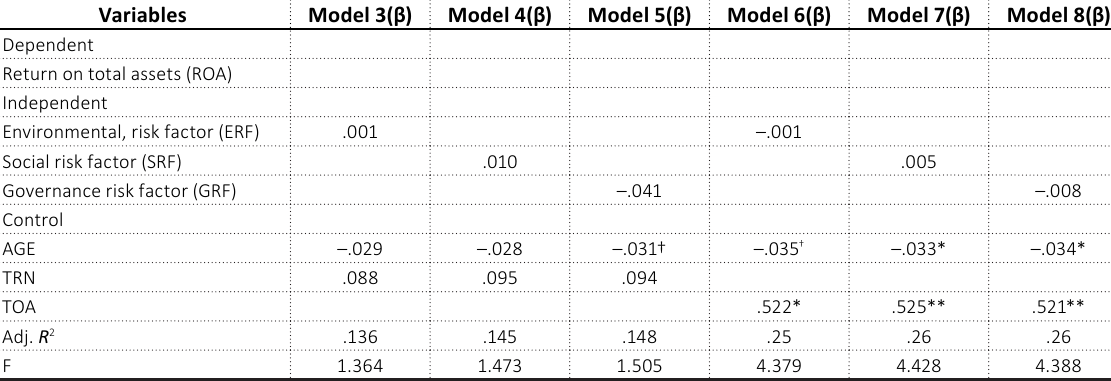
Table 8. Results of regression analysis for environmental, social, and governance scores as independent variables controlled for size